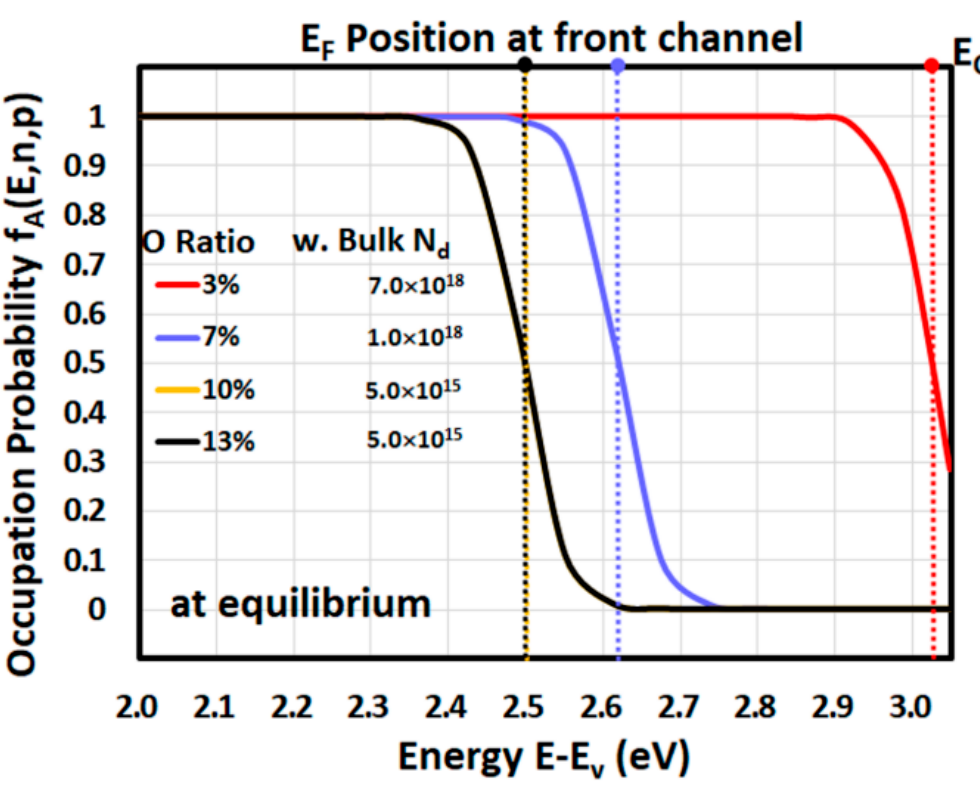
Figure 4. Occupation probability of electrons f(E) and the Fermi level positions determined when f(E) = 0.5 at front channel for different oxygen ratios of a-IWO.